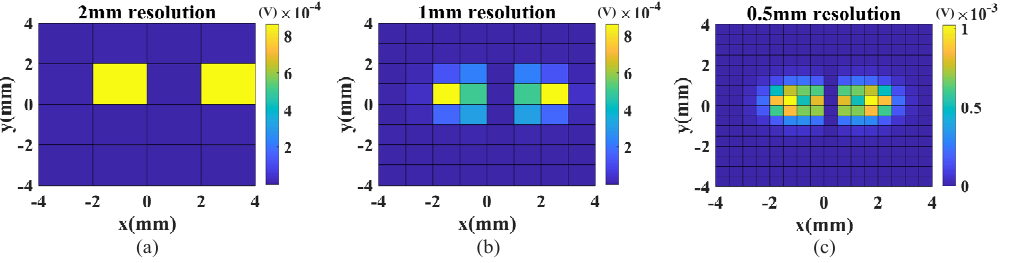
Figure 6. Simulation results: images of the horizontal defect with different spatial resolutions: ( a ) 2